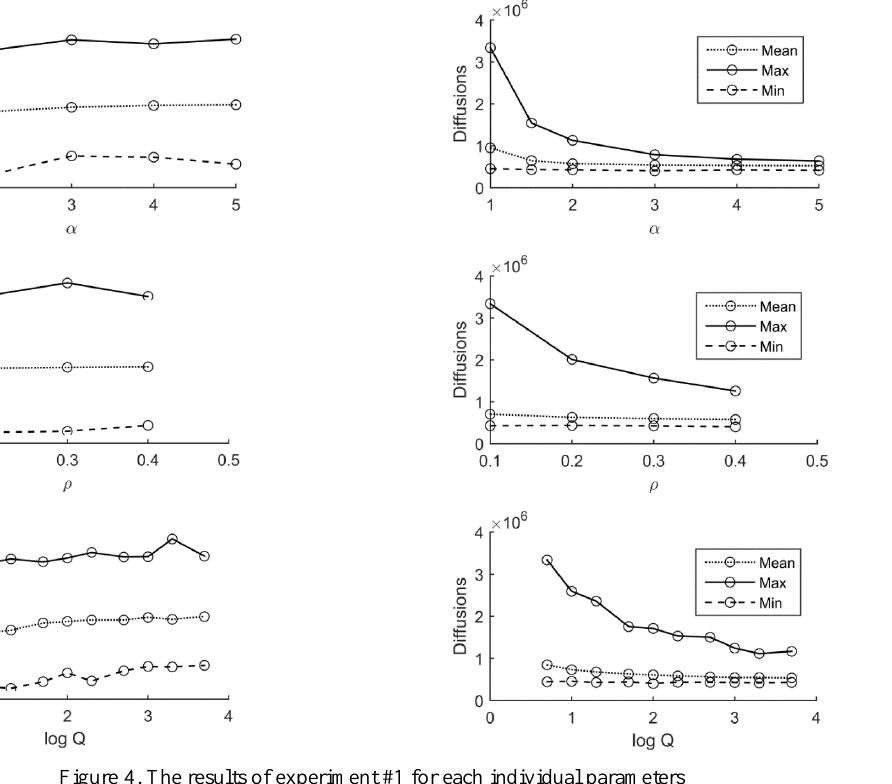
Figure 4. The results of experiment #1 for each individual parameters